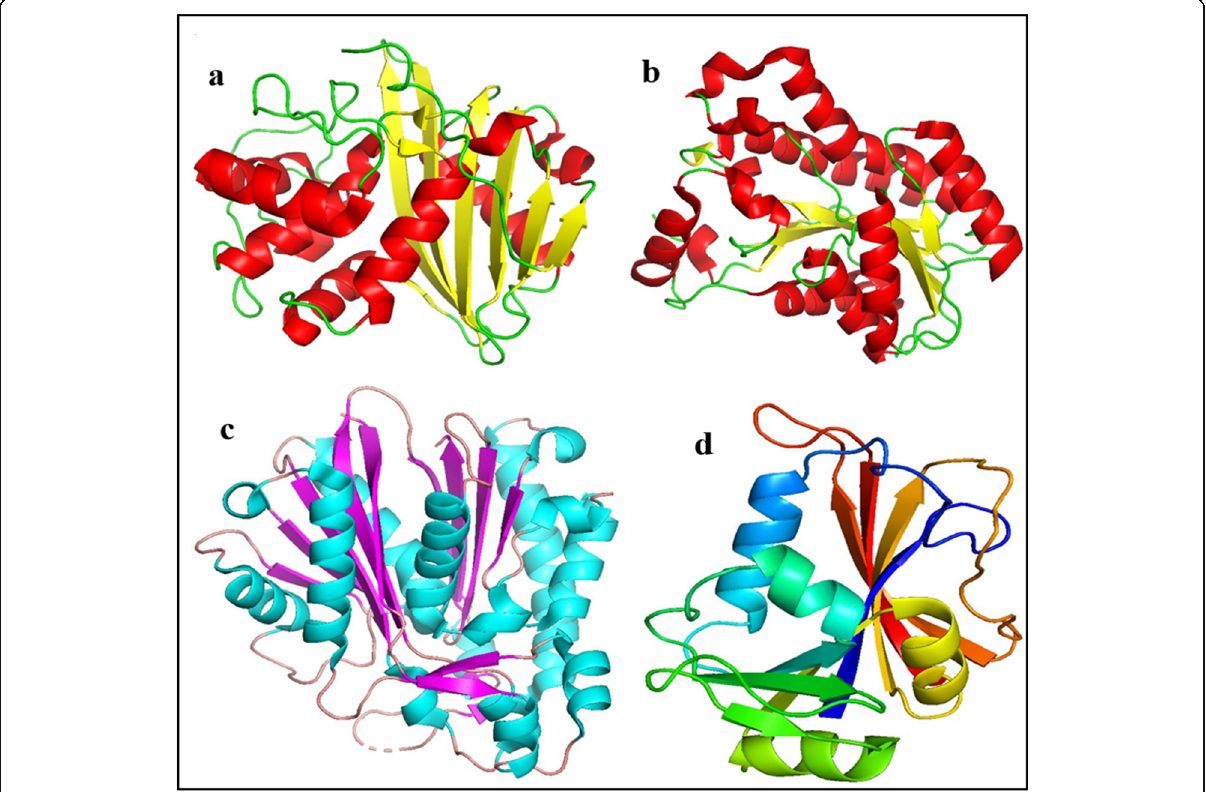
Fig. 2 3D-structure of target proteins. a Beta lactamase (PDB: 3Q81; S. aureus ). b FabI (PDB: 4D41; S. aureus ). c FabH (PDB: 5BNR; E. coli ). d DHFR (PDB: 1RD7; E. coli